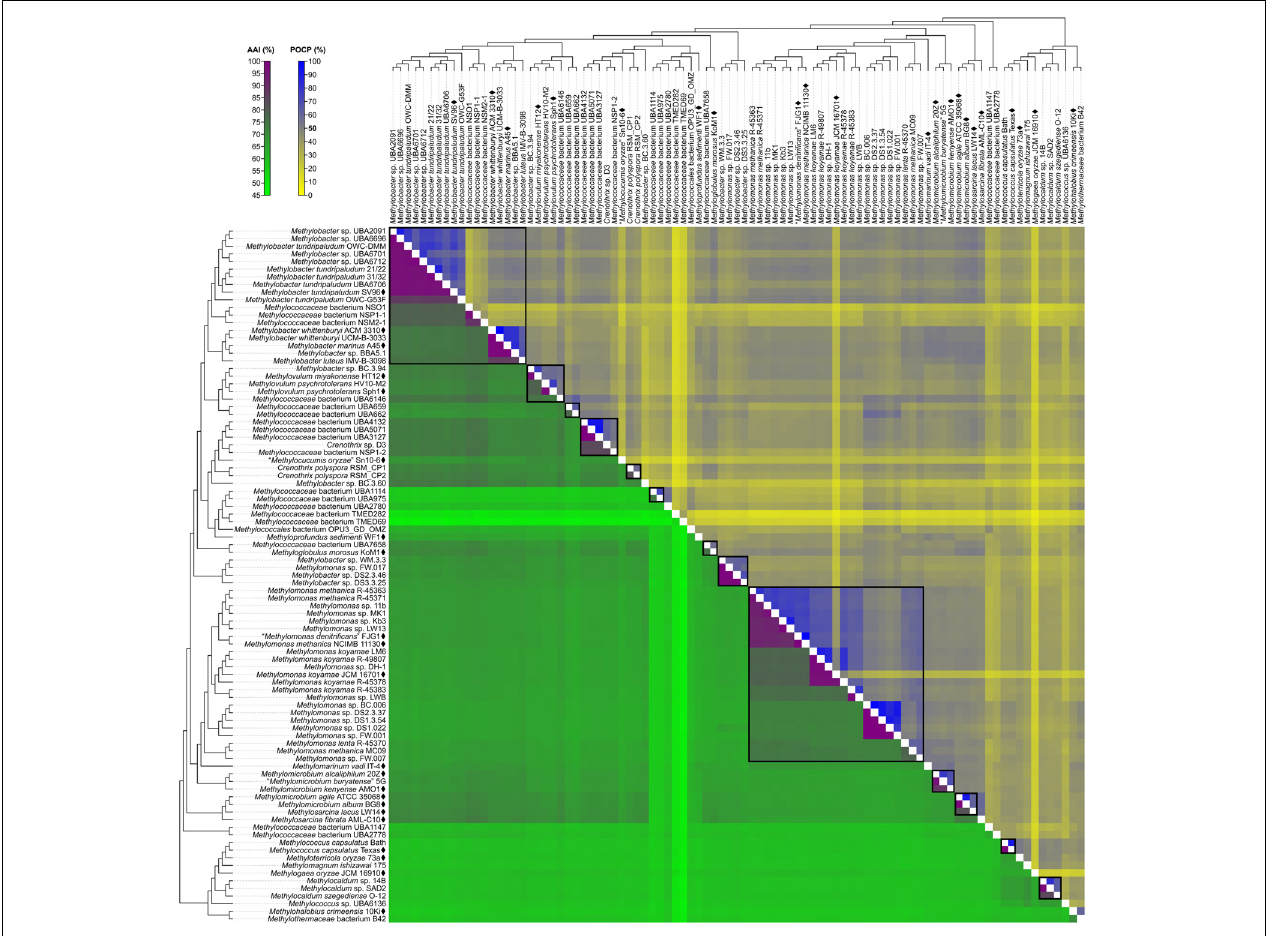
FIGURE 3 | AAI and POCP from pairwise whole-genome comparisons. The heat map shows AAI and POCP values between genomes, along with the tree cladogram to show relationships. Boxed regions indicate inferred genus clusters with at least two members based on AAI comparisons, as well as monophyly in the genome-based phylogeny. POCP was not used to infer